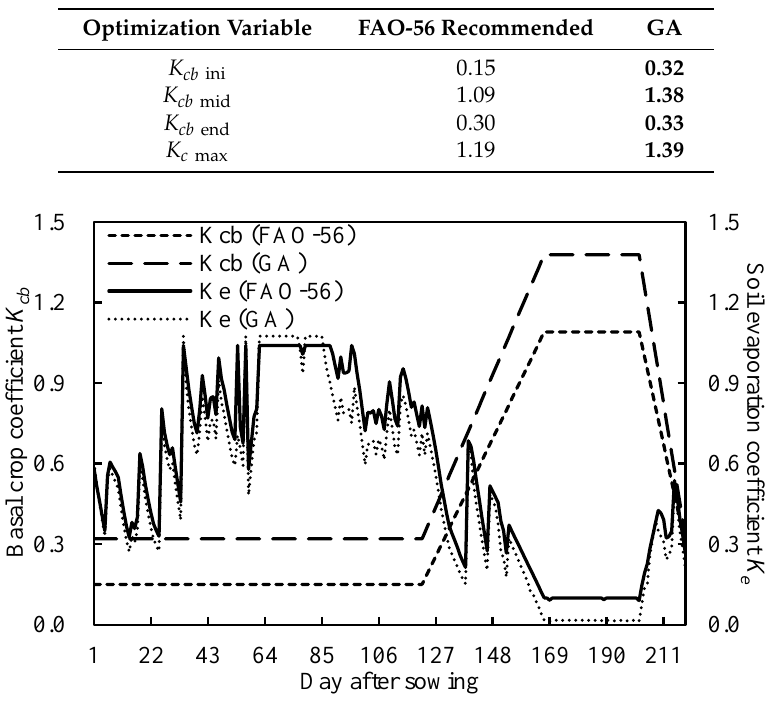
Table 7. Winter wheat crop coefficients suggested by the FAO-56 and optimized by the genetic algorithm (GA).